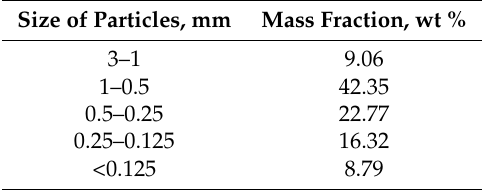
Table 1. Granulometric size composition of the crushed titanomagnetite ore from the Chineisk